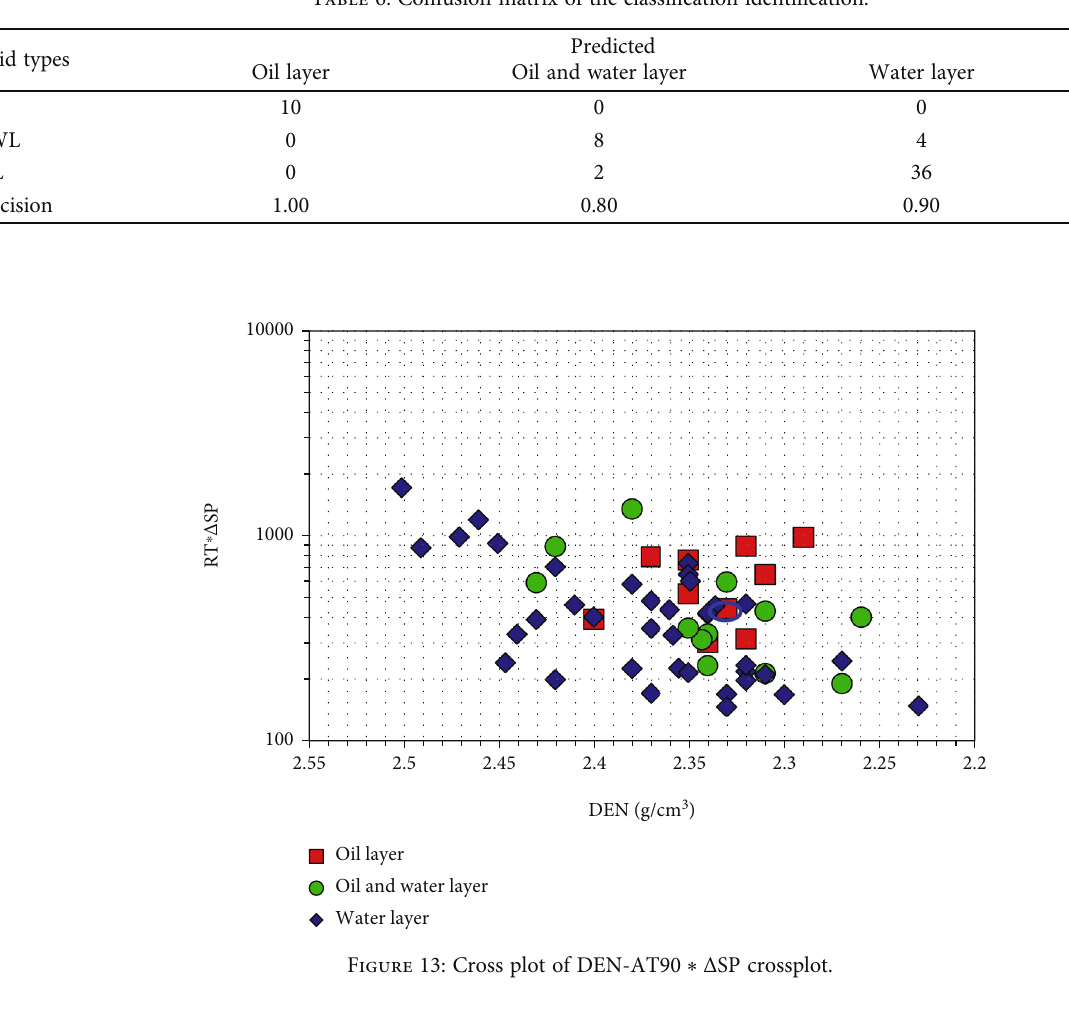
Table 6: Confusion matrix of the classi fi cation identi fi cation.